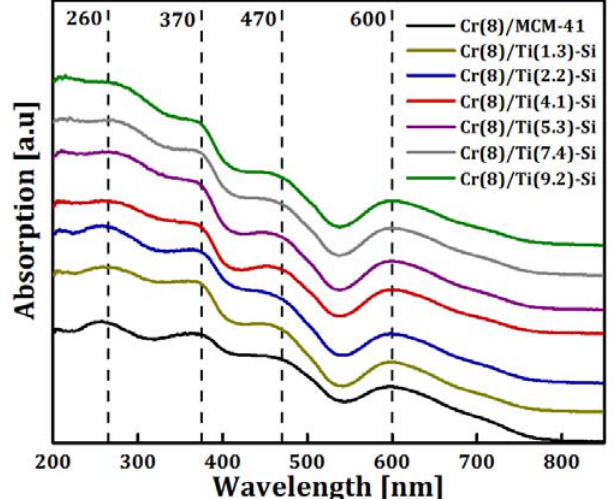
Figure 5. UV–Vis–DR spectra of Cr(8) / MCM-41 and Cr(8) / T(x)–Si catalysts prepared with varying titanium content wt %.